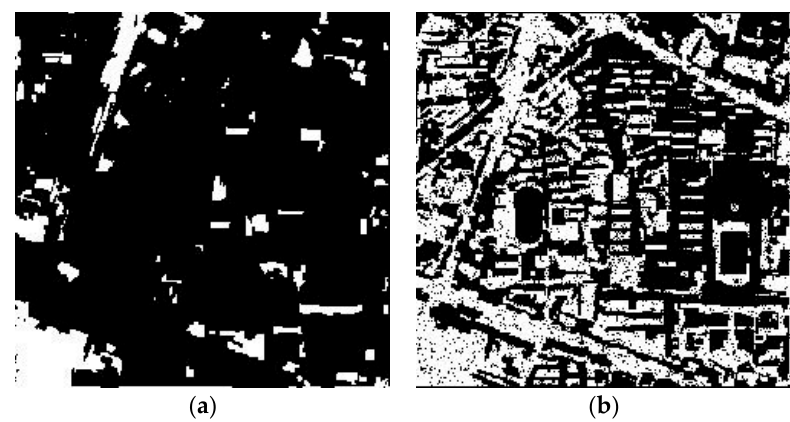
Figure 11. Change detection maps resulting from ( a ) the proposed multi-scale k -means method and ( b ) the method using varying geometric and radiometric properties [35], with L2 as the basis image in the first study area (scale = 50).